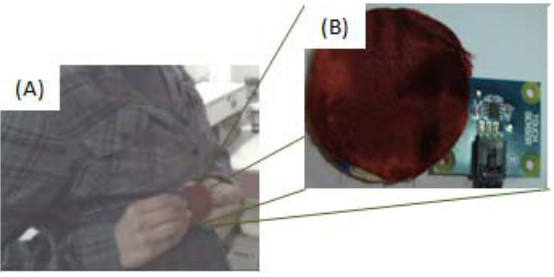
Figure 19. Smart button used to capture the caregiver´s decision ( A ), implemented using a touch sensor ( B